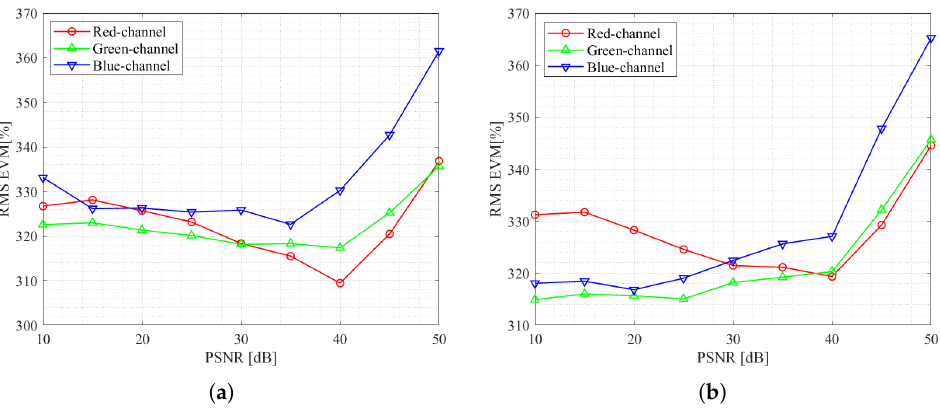
Figure 13. Comparison of EVM according to PSNR. ( a ) 128 × 128 pixel size. ( b ) 256 × 256 pixel size.